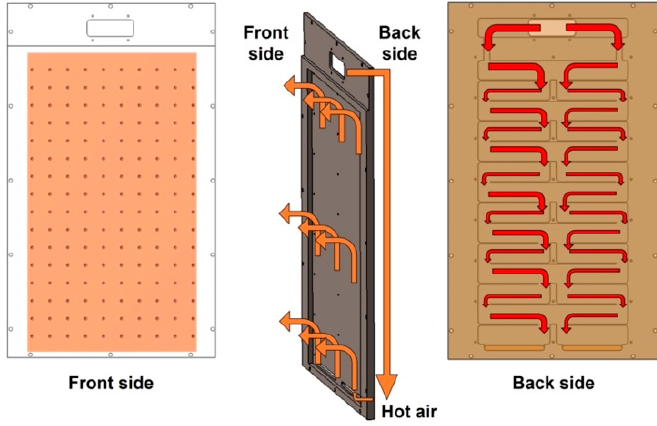
Figure 4. Aluminum plate for the hot air flow channel.